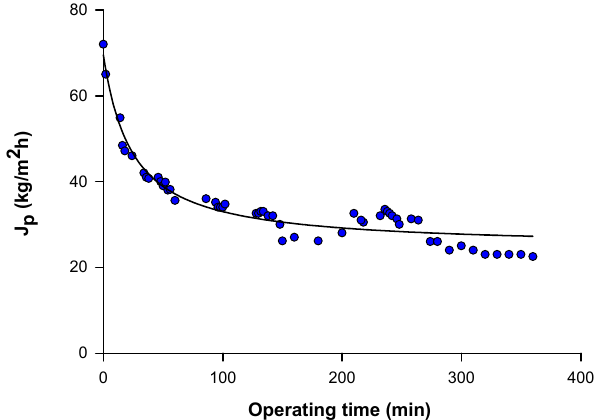
Figure 2. Microfiltration of pre-treated olive mill wastewaters. Time course of permeate flux (transmembrane pressure, 1.6 bar; feed flowrate, 6 m 3 /h; temperature, 25 ± 1 °C).